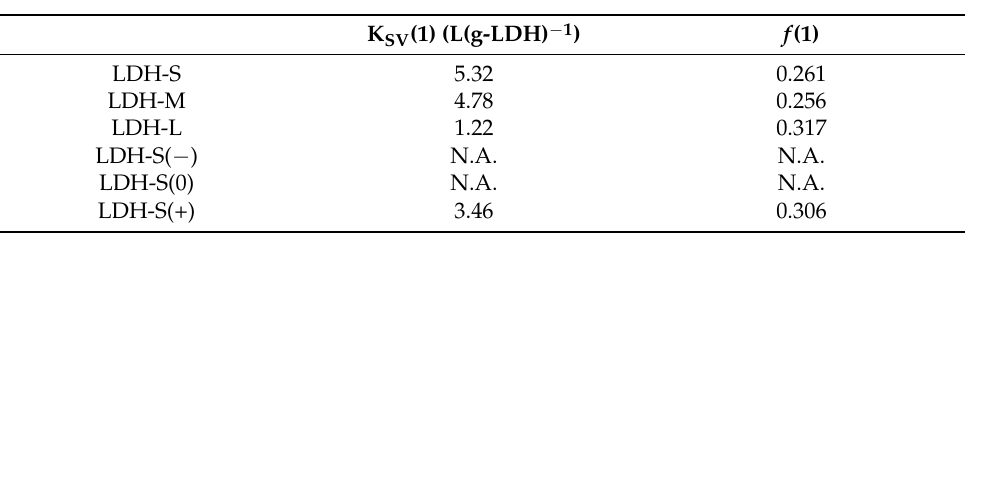
Table 2. Fitting parameters for modified Stern–Volmer plots for fluorescence quenching of blood plasma by the